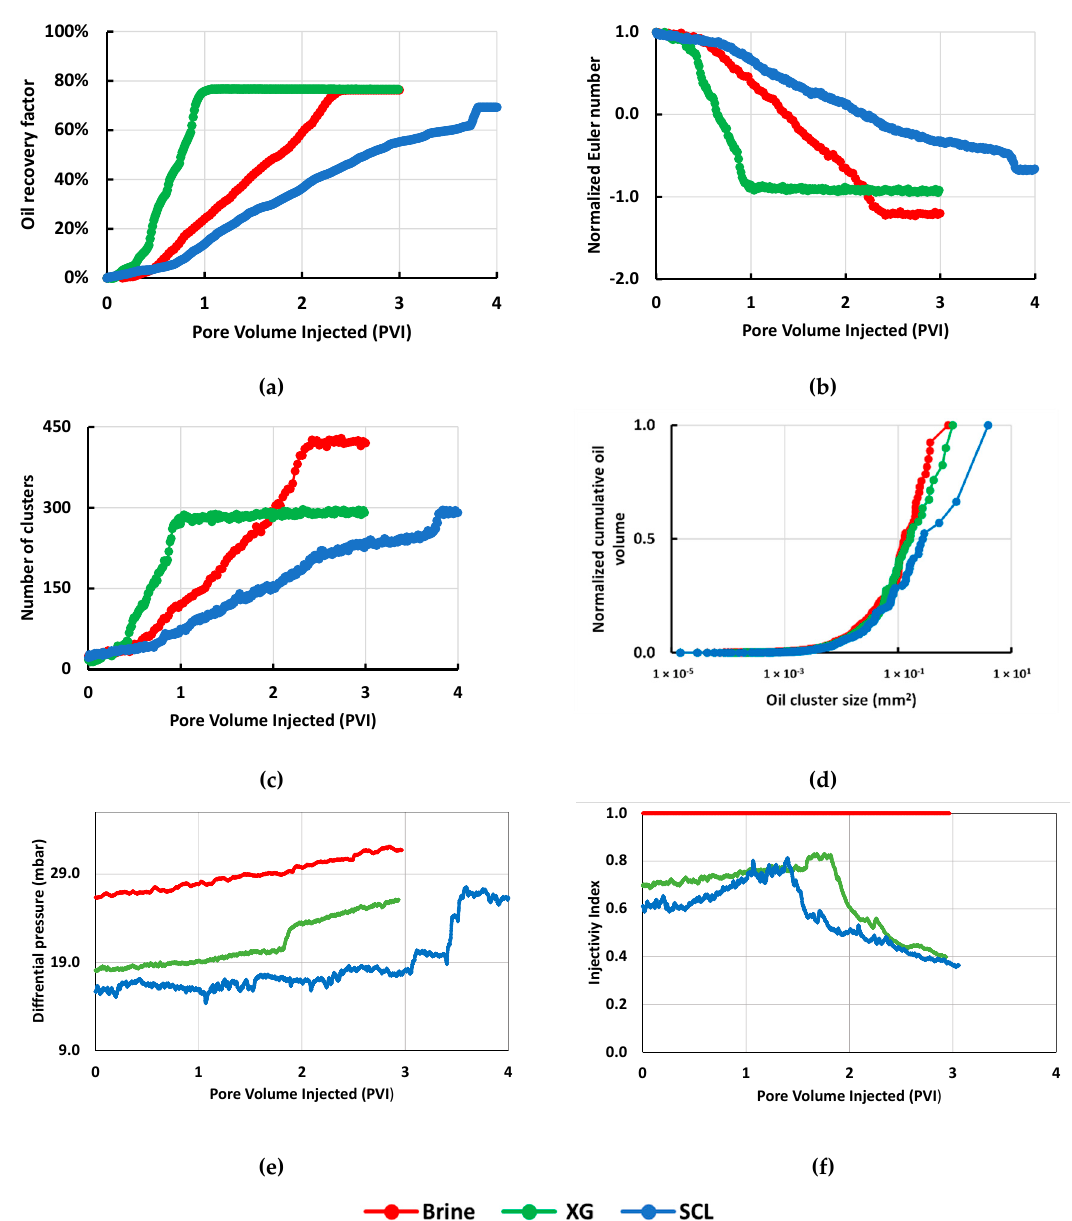
Figure 6. Microfluidic results for screening of biopolymer solutions at N c = 1 × 10 − 6 : ( a ) Oil recovery factor; ( b ) Normalized Euler number; ( c ) Number of clusters; ( d ) Normalized cumulative oil volume; ( e ) Differential pressure; ( f ) Injectivity index.